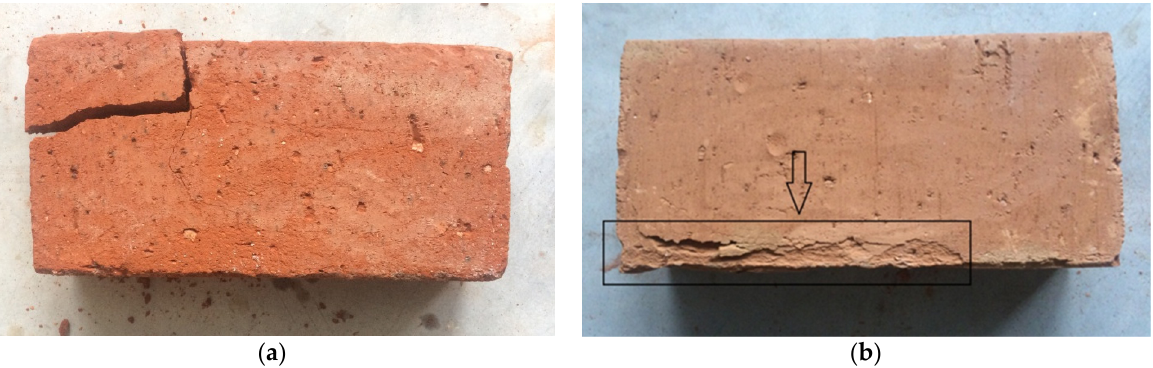
Figure 4. The appearance of non-resistant bricks after the freeze-thaw study: ( a ) complete damage (historic brick), ( b ) damage in the form of delamination (factory-made